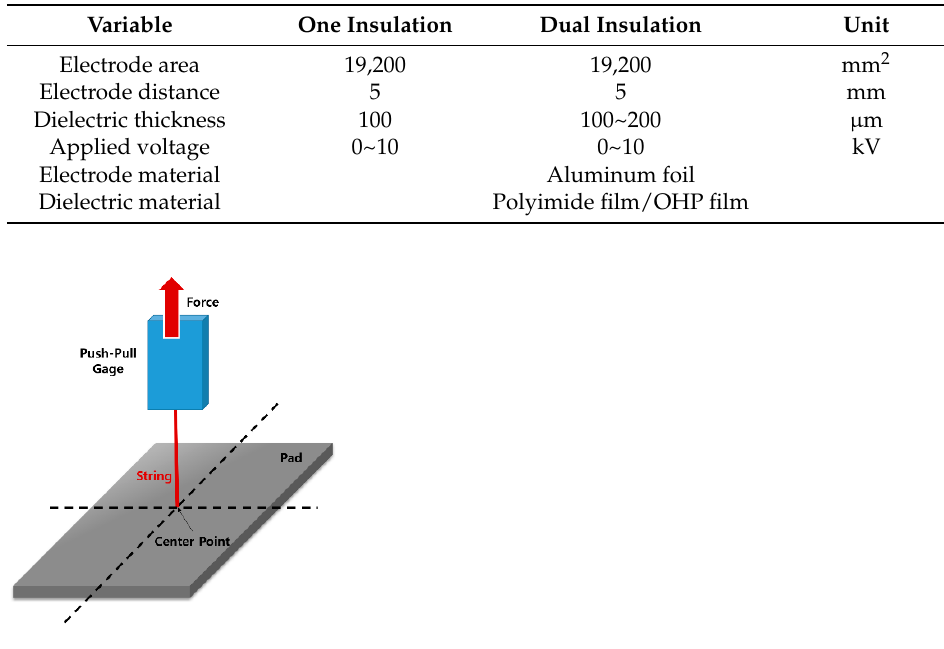
Figure 3. Holding force measurement between the attachment face and the electroadhesion